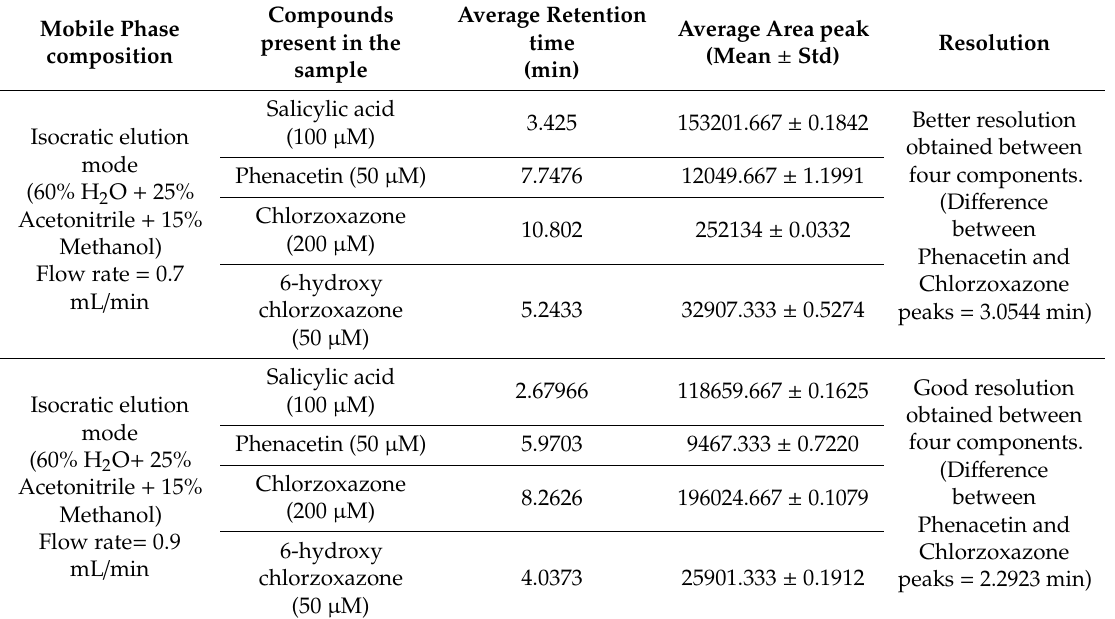
Table A3. Variation in retention time, and area peak between compounds when changing the flow